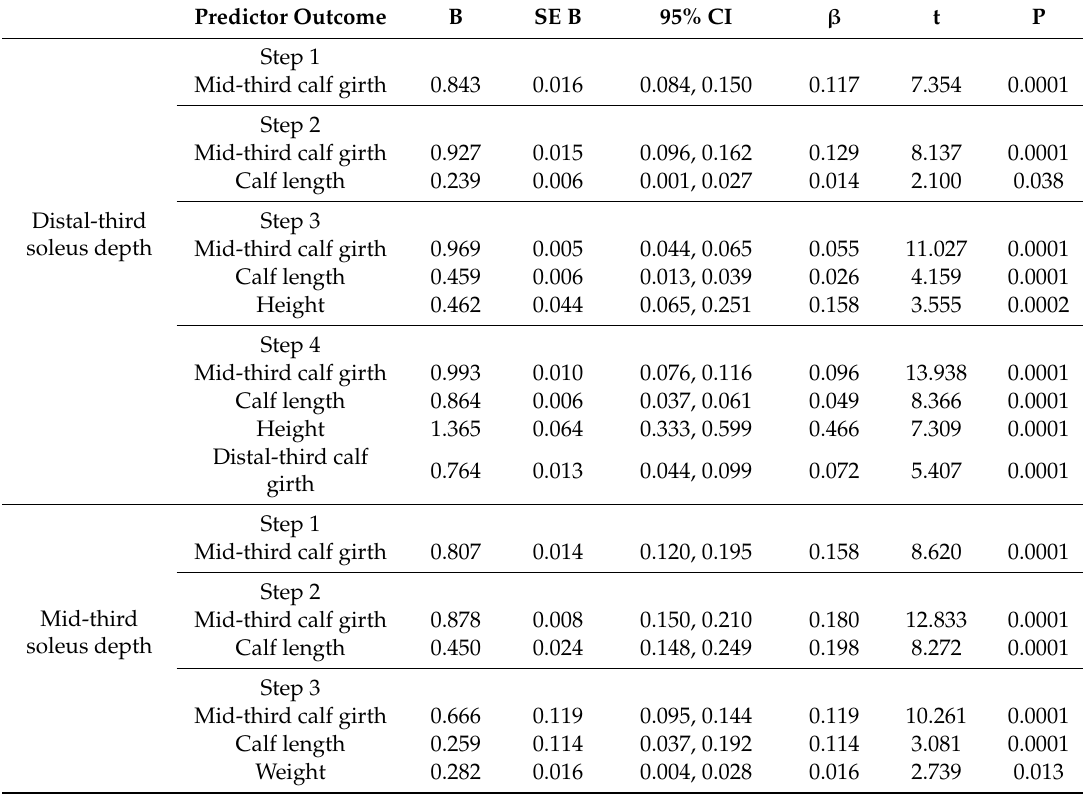
Table 4. Summary of the Regression Analyses to determine Predictors of Soleus Depth in